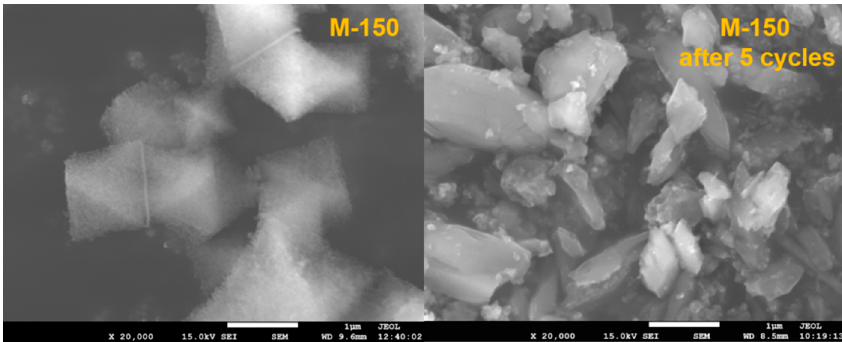
Figure 12. SEM micrographs of M-150 before and after the recycling experiments.